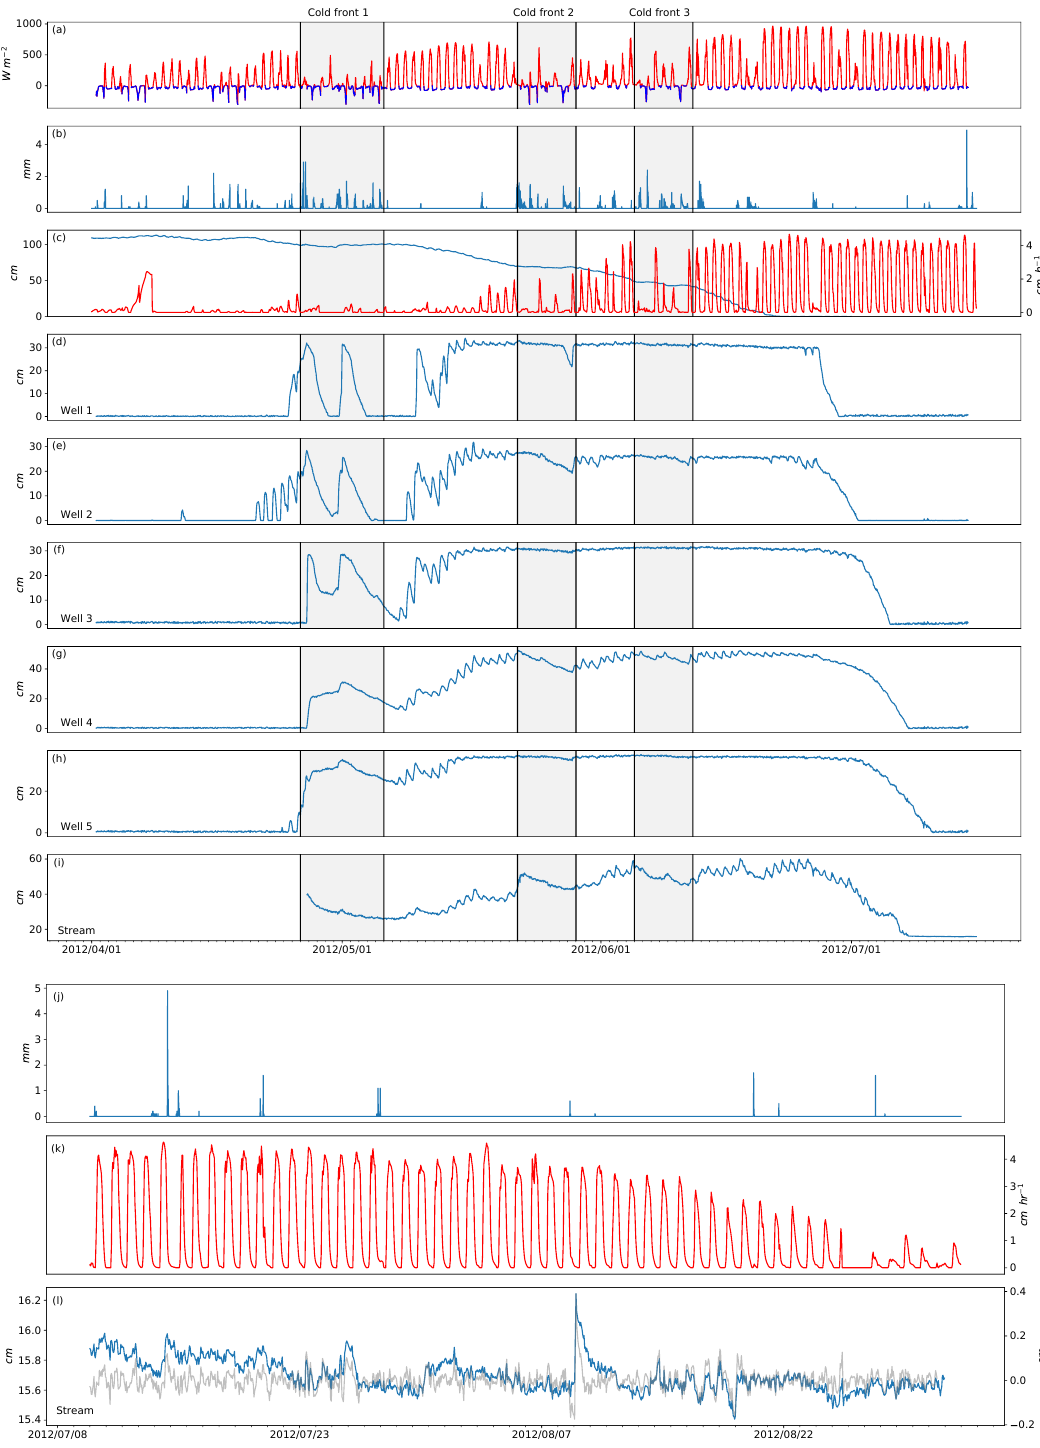
Figure 2. Time series of atmospheric inputs and hydrologic states; (a) net radiation, Wm − 2 ; (b) precipitation, mmday − 1 ; (c) snow water equivalent (blue line), cm, and relative sap velocity (red line), cmh − 1 ; (d–h) pressure head in piezometers 1 to 5 (blue line), cm; (i) pressure head in stream (blue line), cm. The grey shaded area indicates three major cold storms during the study period. The bottom three panels (j–l) extend the time series of (j) precipitation, mmday − 1 ; (k) relative sap velocity, cmh − 1 ; and (l) pressure head (blue line) and detrended pressure head in stream (grey line), cm, for the summer period. Note the different scale on the y axis in panels (j–l) with respect to (b , c , and i)